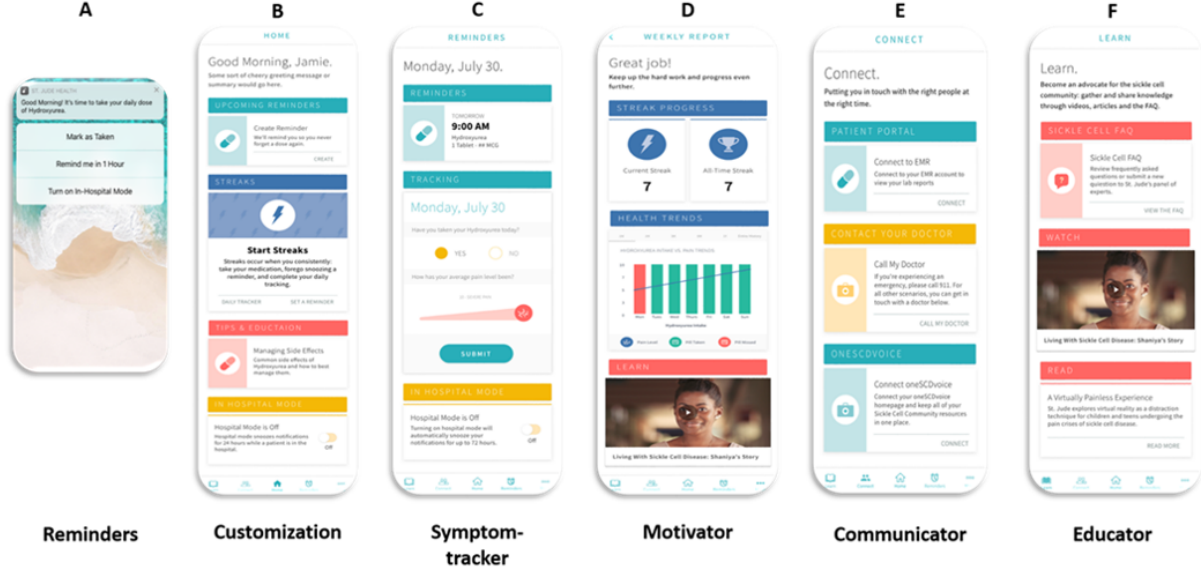
Figure 2. Features of the InCharge Health app for patients. (A) Push notifications will come daily and will prompt the patient participant to mark if the dose was taken, not taken, or be reminded later. (B) Customization of the push notification messages, time of the day, and choice of the accountability partner. (C) A daily pain and mood tracker is available and captures pain level and mood changes. (D) Graphing of pain level versus pain is available for the past 7 days. (E) A link to the patient portal accesses the patient’s electronic medical chart, clinic numbers, and patient-led discussion forums. (F) A large resource bank is available with links to vetted educational websites, educational material, and educational videos and is